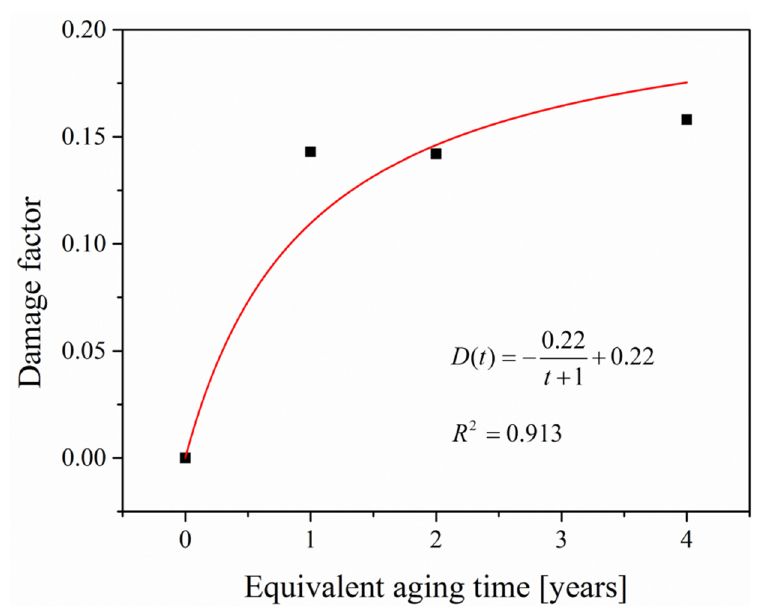
Figure 11. Damage factor–equivalent aging time curve.